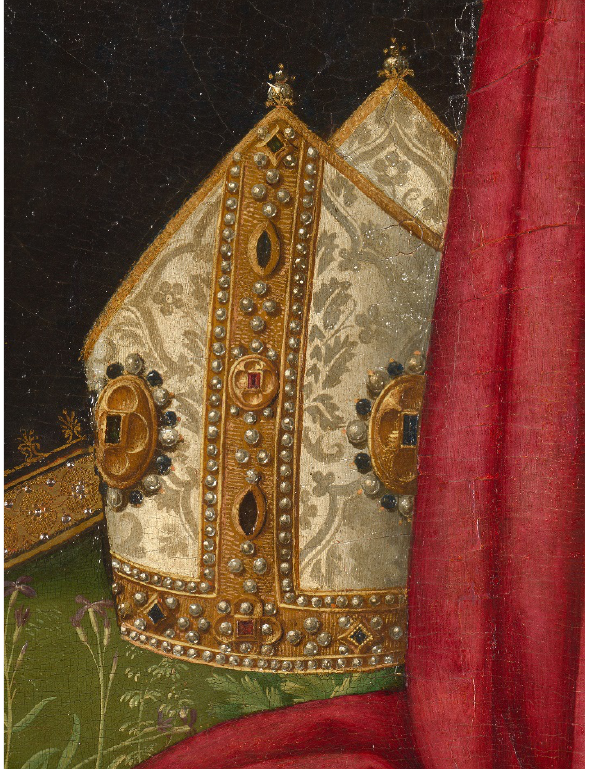
Figure 15 . Ornamental and detailed treatment of the mitre.